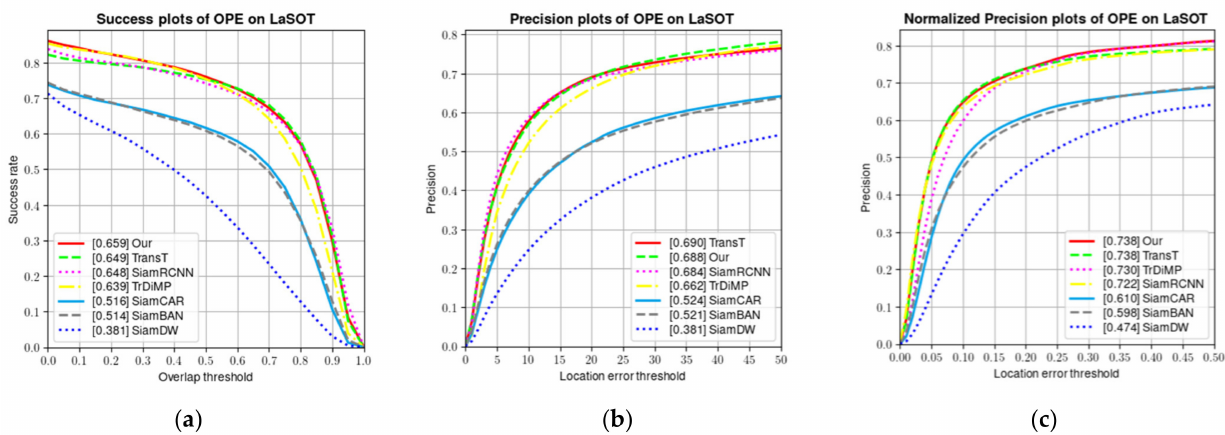
Figure 6. Comparison of the success rate and accuracy of the proposed algorithm with baseline algorithm and other advanced tracking algorithms. ( a ) Success plots; ( b ) precision plots; and ( c ) normalized precision